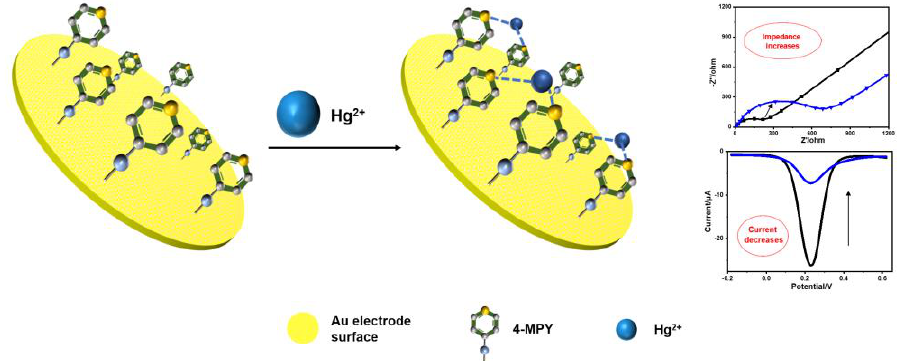
Figure 1. Schematic illustration for the Hg 2+ detection process of 4-MPY-modified Au electrode.